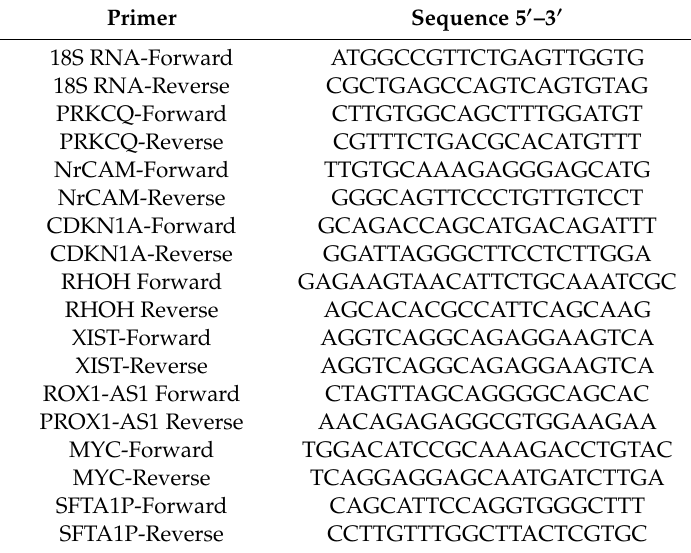
Table 1. Primers for targets